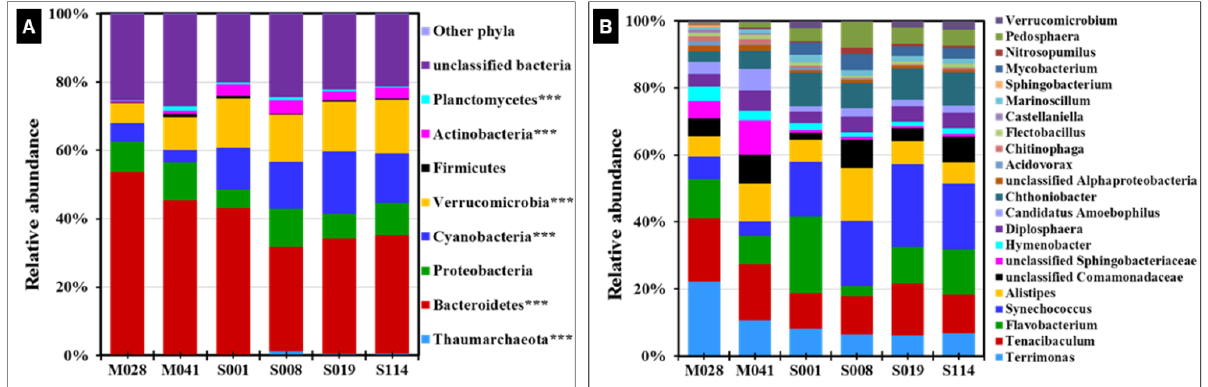
Figure 6. Stacked bar chart representing the relative abundance of different ( A ) phyla and ( B ) gen- era/families across various sampling locations in Lakes Michigan and Superior. The top 22 taxa, by abundance, are shown for clarity. Significant differences among the lake types were computed using one-way ANOVA with Tukey’s post hoc test for multiple comparisons, *** p < 0.0001. Significantly different phyla/genera/families among the lakes are shown in the figure description.